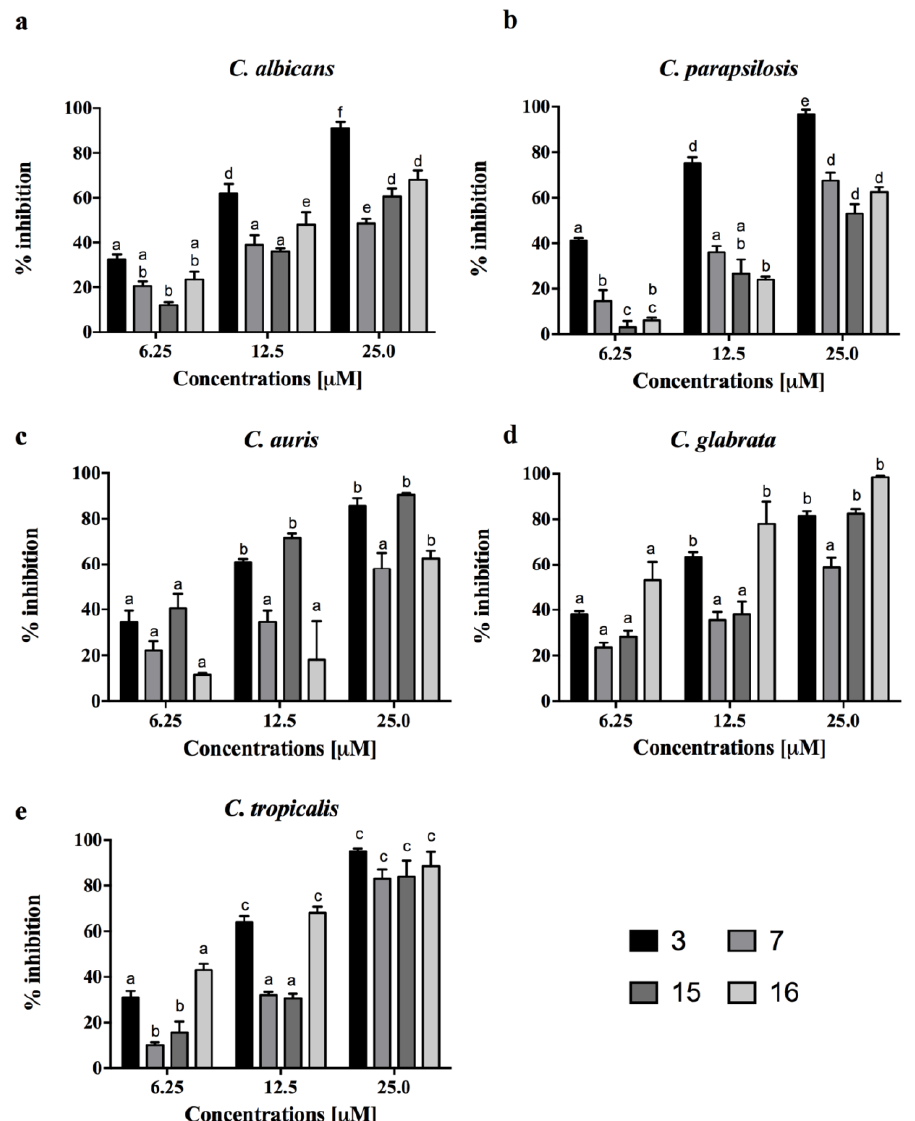
Figure 2. Dose-dependent (6.25, 12.5 or 25.0 µ M) biofilm inhibition by peptides 3 , 7 , 15 and 16 against C. albicans , C. auris , C. glabrata , C. tropicalis and C. parapsilosis , quantified with crystal violet after 24